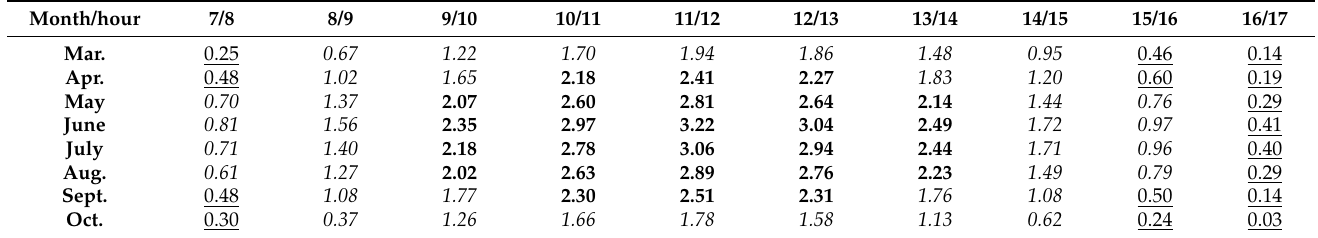
Table 6. Monthly average hourly UVB irradiation dose available (MED) for Skin Type 2 at the Dead